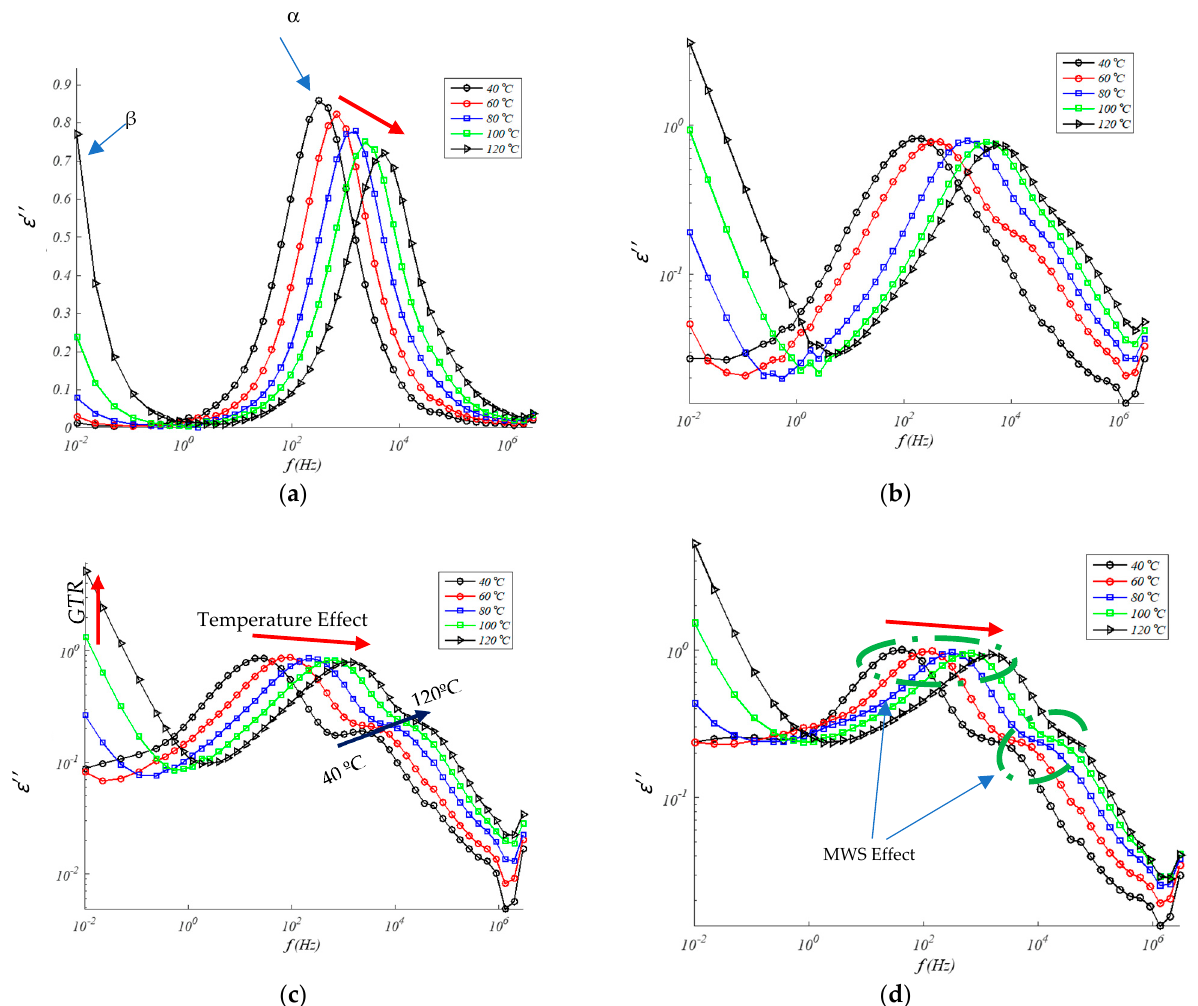
Figure 5. Imaginary permittivity in EPDM composites for: ( a ) 0% GTR or neat EPDM; ( b ) EPDM + 5% GTR; ( c ) EPDM + 10% GTR; ( d ) EPDM + 20% GTR.